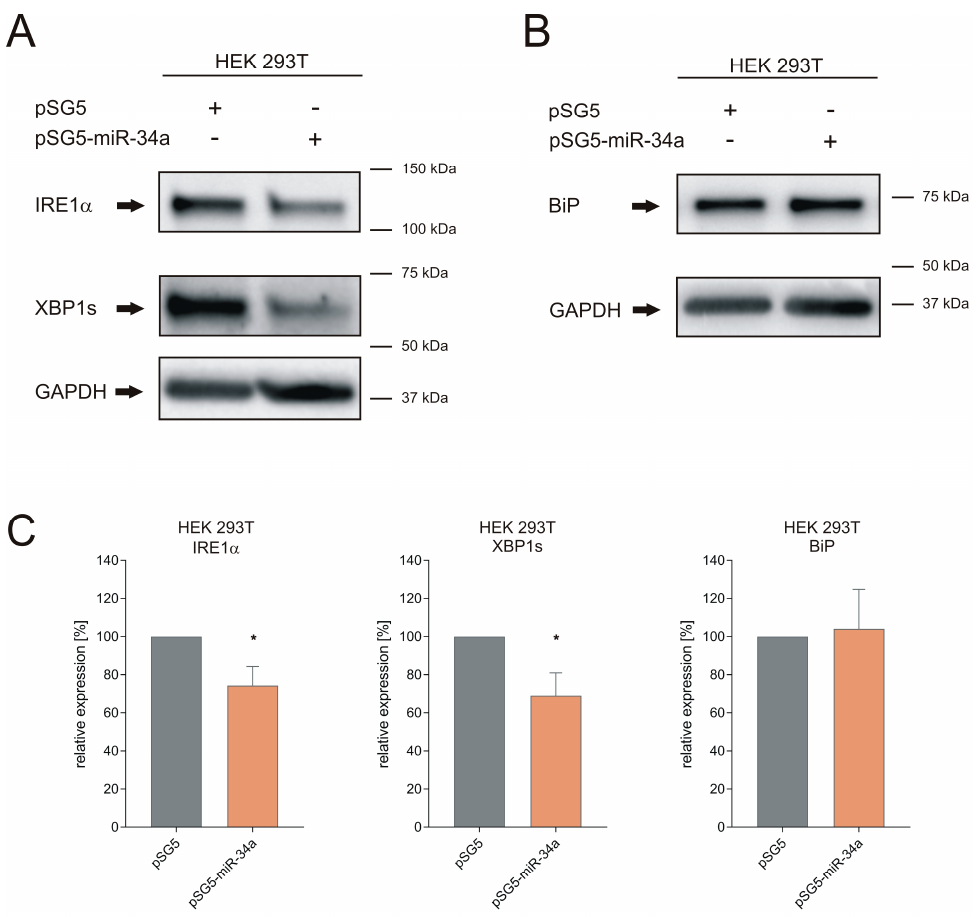
Figure 3. Detection of BiP, IRE1 α and XBP1s endogenous protein after miR-34a transfection. ( A , B ) Representative western blots for IRE1 α , XBP1s and BiP. HEK293T cells were transfected with pSG5 or pSG5-miR-34a expression plasmid for 48 h. Changes in protein level were detected by specific antibodies against IRE1 α , XBP1s and BiP. GAPDH served as an endogenous control. ( C ) Quantification of IRE1 α , XBP1s and BiP protein level. Western blots were quantified by densitometry by Image Lab Software and normalized to GAPDH. Data represent mean ± SEM of four independent experiments (* = p ≤ 0.05).